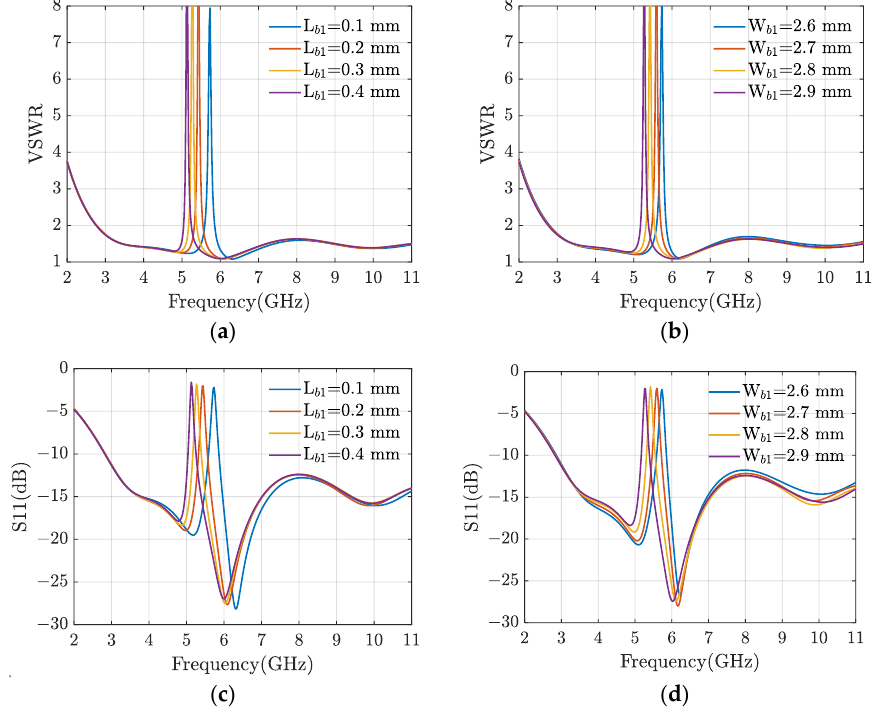
Figure 11. Schematic diagram of interdigital inductance slots. ( a ) VSWR under different L b 1 . ( b ) VSWR under different W b 1 . ( c ) S11 under different L b 1 . ( d ) S11 under different W b 1